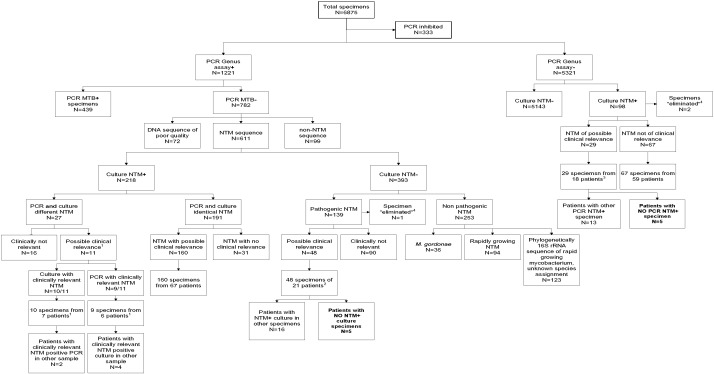
Workflow of clinical specimens studied using the COBAS™ TaqMan™ Mycobacterium genus assay.Abbreviations: MTB: Mycobacterium tuberculosis; NTM: nontuberculous mycobacteria.1For details: see Table S6 in the Supplemental materials; in total 8 patients, 7/8 patients had a culture with a clinically relevant NTM and 6/8 patients had a PCR with a clinically relevant NTM.2For details: see Table S7 in the Supplemental materials.3For details: see Table S8 in the Supplemental materials.4Specimen eliminated due to lacking clinical information.